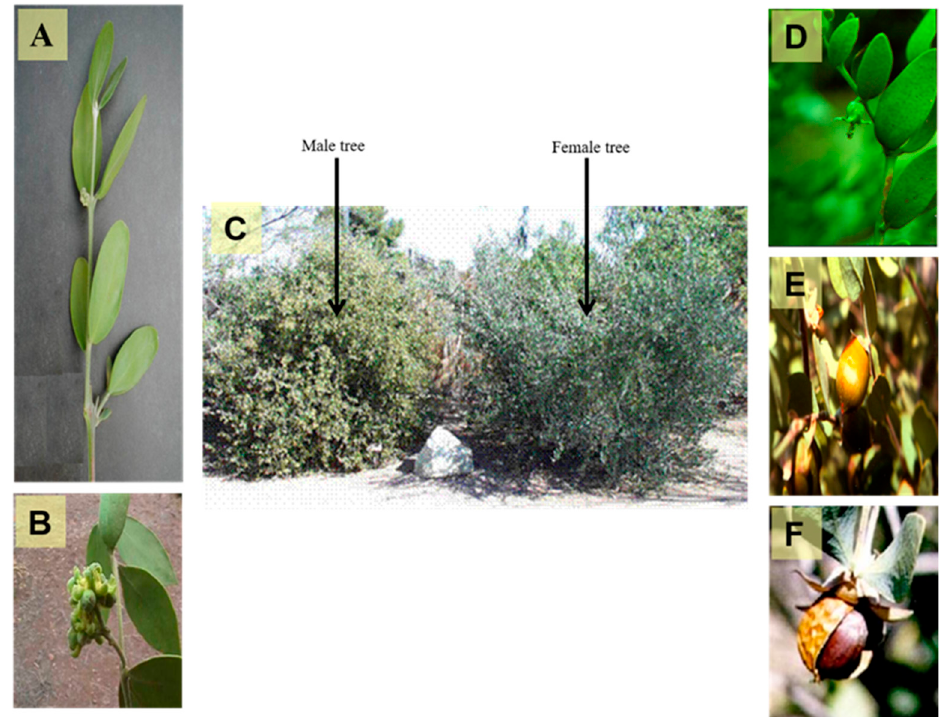
Figure 1. A photograph showing different organs of Simmondsia chinensis , ( A ) Branch of the plant (X 0.8), ( B ) Male flowers (X 1.0), ( C ) Old male and female trees (X 0.02), ( D ) Female flower (X 0.5), ( E ) Ripe fruit (X 0.5) and ( F ) Seed (X 0.8) (Photographer Eng. Nabil Elmougi, the jojoba farms of The Egyptian Natural Oil Company, Ismailia Desert Road, Egypt).